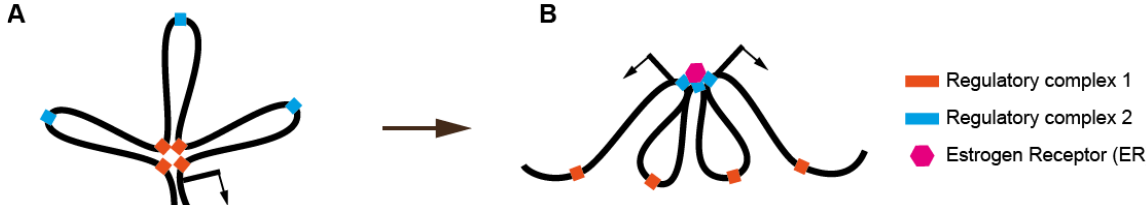
Figure 2. Alterations to the three-dimensional organization of chromatin are linked to transcriptional changes induced by exposure to environmental estrogens. In this illustration, exposure to environmental estrogens is used as an example to demonstrate a potential mechanism by which nutrition could affect 3-D chromatin organization and the transcriptional regulation of multiple genes. ( A ) Transcription from a promoter (arrow) that is regulated in a cell type-specific manner by a regulatory complex assembled by long distance connections that form DNA loops. Regulatory elements outside of the cluster (blue) are not connected and do not drive transcription; ( B ) Inappropriate exposure to estrogen activates the estrogen receptor (ER), which contacts specific regulatory sites (blue) and activates specific gene expression. The formation of an ER-nucleated cluster breaks existing DNA-DNA contacts, and not only inappropriately activates gene expression (arrows) but also disrupts normal gene expression that existed within the original chromatin architecture in